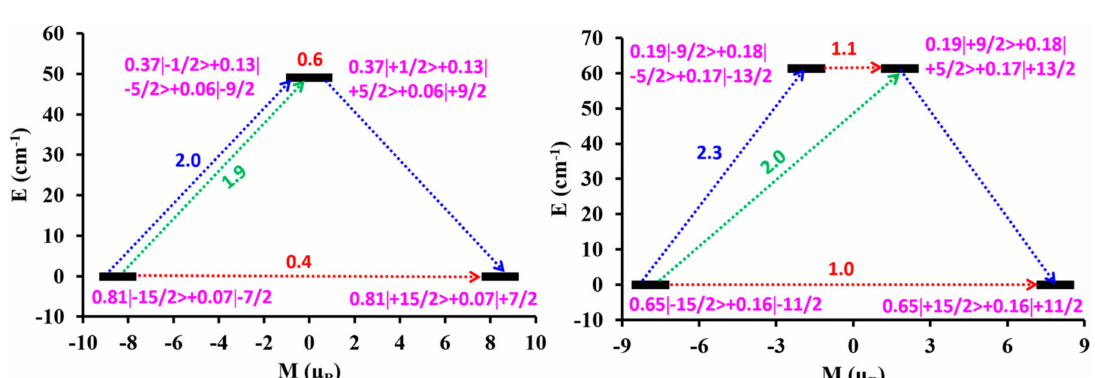
Figure 8. Magnetization blocking barrier for the Dy III site in the model complexes ( left ) a and ( right ) b